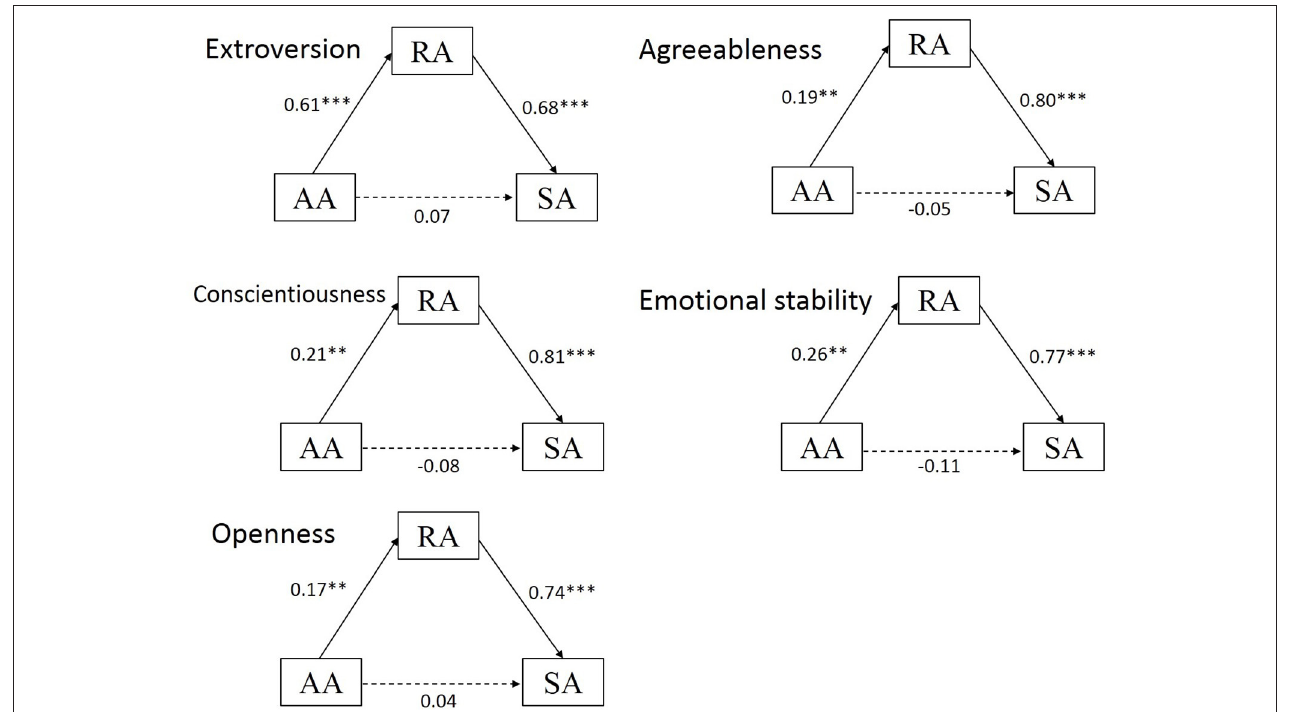
FIGURE 1 | Mediation models of the effect of actual appraisals of peers and self-appraisals via reflected appraisals. SA, self-appraisals; RA, reflected appraisals; AA, actual appraisals of peers; M, mean; ** p < 0.01 and *** p < 0.001.